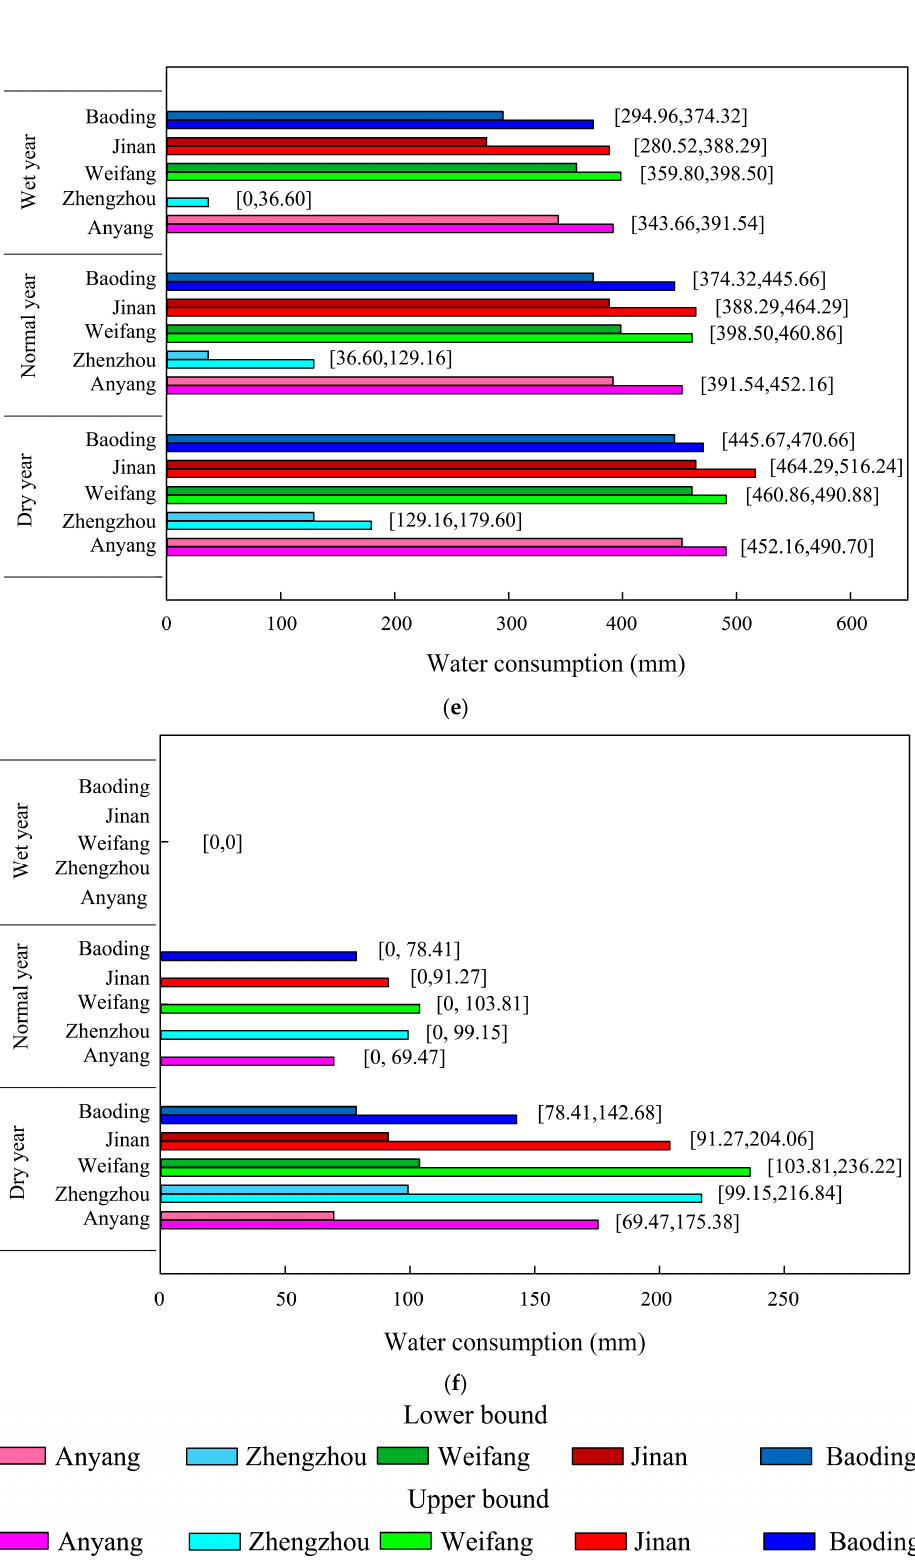
Figure 7. Interval parameters for the prediction of irrigation water allocation in five cities. ( a ) Lower bound of irrigation water allocation in 2020; ( b ) upper bound of irrigation water allocation in 2020; ( c ) lower bound of irrigation water allocation in 2021; ( d ) upper bound of irrigation water allocation in 2021; ( e ) upper bound of irrigation water allocation in 2022; and ( f ) upper bound of irrigation water allocation in